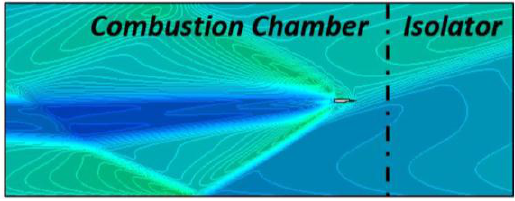
Figure 31. Isolator-injector shockwave interaction.